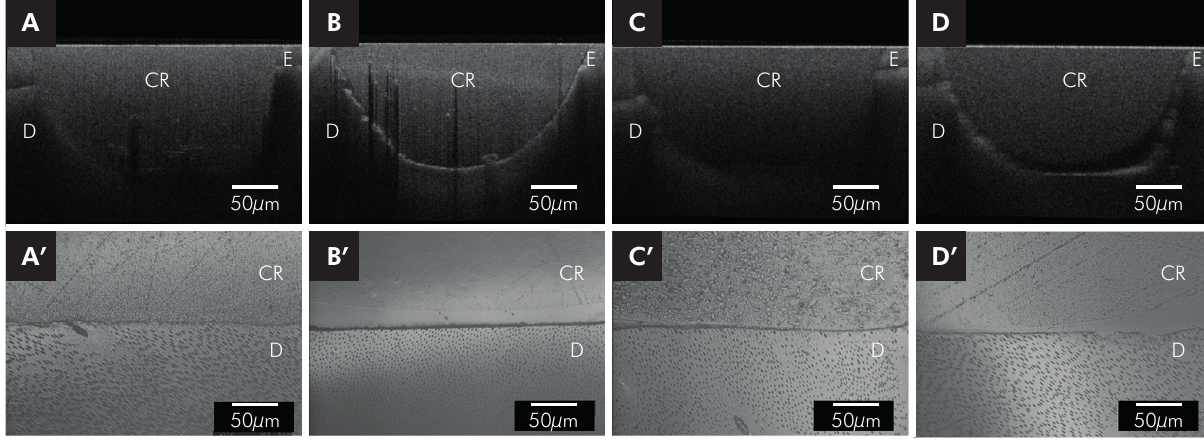
Figure 8. Representative 2D OCT image slices of each restorative system (a-d) and the corresponding CLSM (a’-d’). The presence of gaps at the bottom of the restorations are better visualized with CLSM at a 1250x magnification. Images are ordered as follows: (a,a’) HER/OBF; (b, b’) TEC/TNB; (c,c’) SDR/XPB; (d,d’)